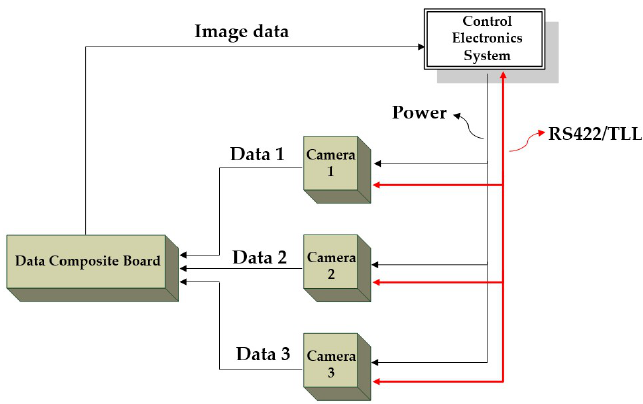
Figure 6. System block diagram.